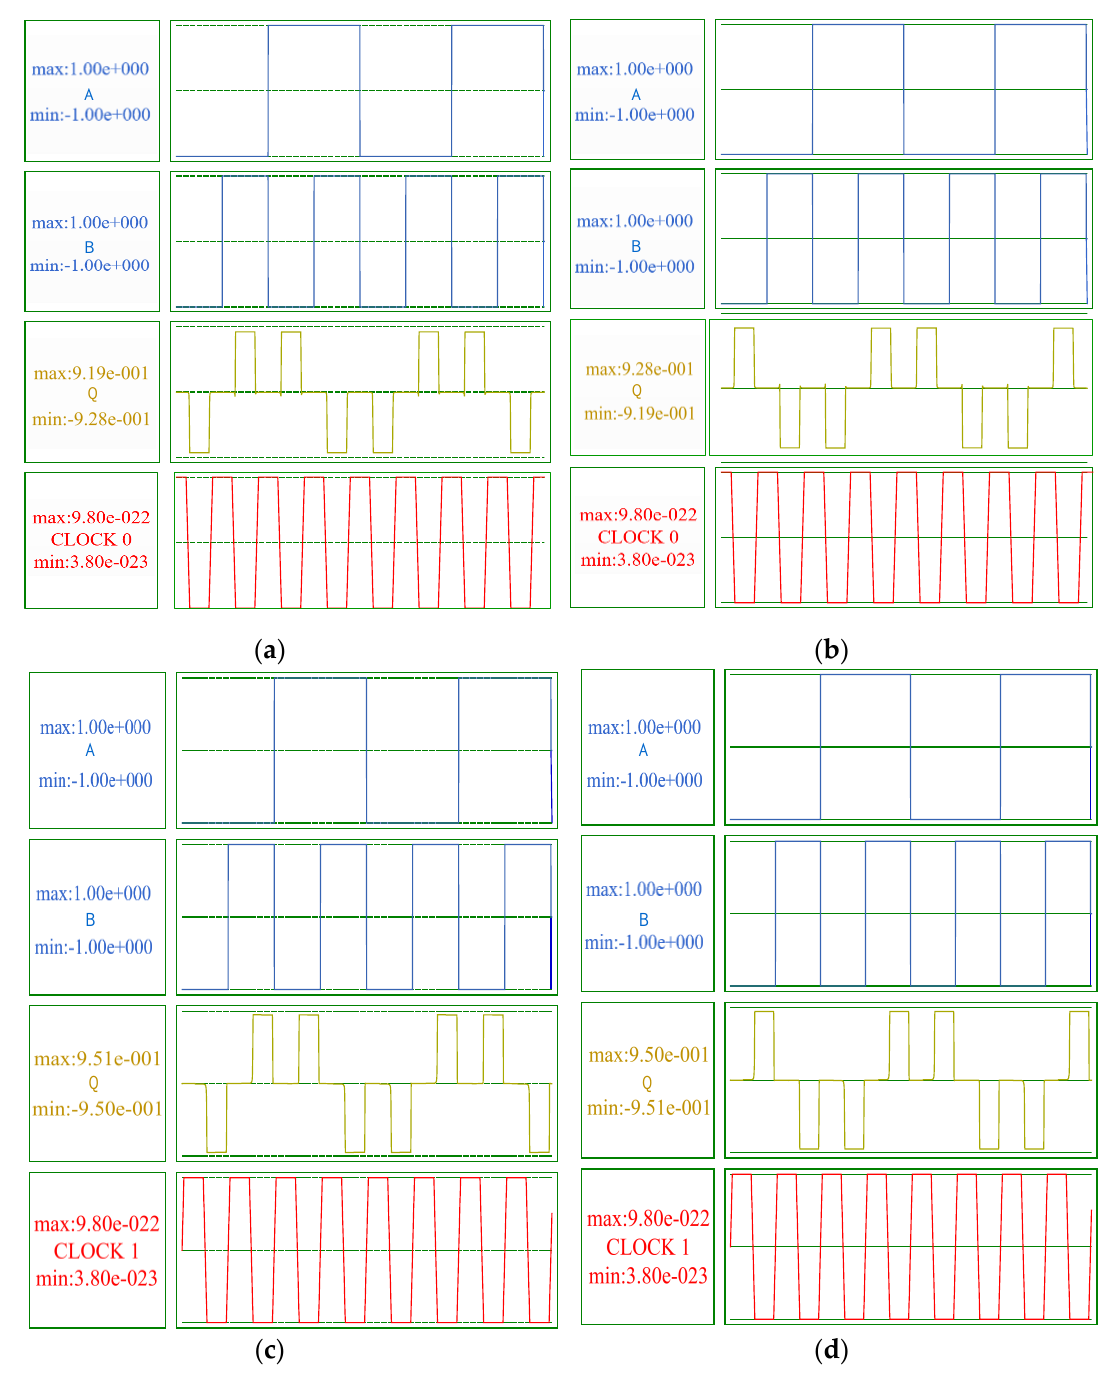
Figure 6. Simulation results of the proposed XOR/XNOR gates. ( a ) The first XOR gate (XOR1), ( b ) the first XNOR gate (XNOR1), ( c ) the second XOR gate (XOR2), and ( d ) the second XNOR gate (XNOR2). Table 3. Comparisons of the performance and energy dissipation for alternative XOR/XNOR gates.